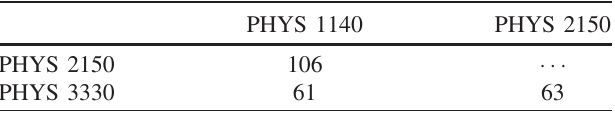
longitudinal populations in our data. The 33 students for whom we have fully longitudinal data are included in all applicable partially longitudinal populations, and thus appear multiple times in these counts.